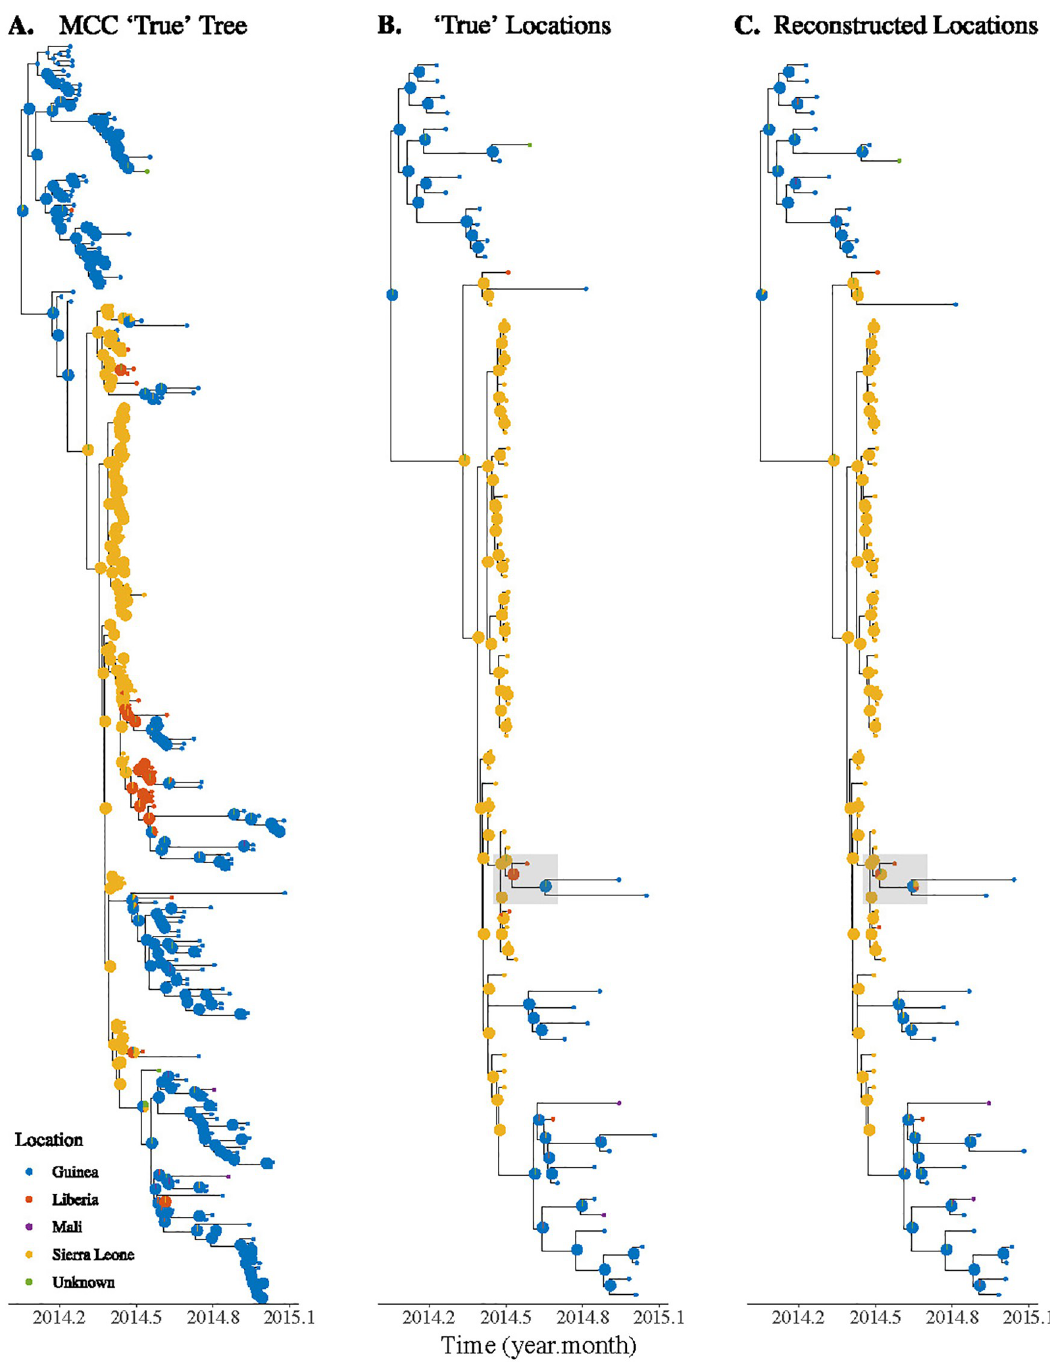
Fig 5. Ancestral state reconstruction of Ebolavirus trees with recent migrants downsampled. Panel A: The Maximum Clade Credibility (MCC) tree of Ebolavirus sequences generated using BEAST, which is used as the true tree. Downsampled trees obtained by dropping 80% recent migrants with either the true ancestral locations (Panel A) or ancestral locations reconstructed after downsmapling migrants (Panel C).